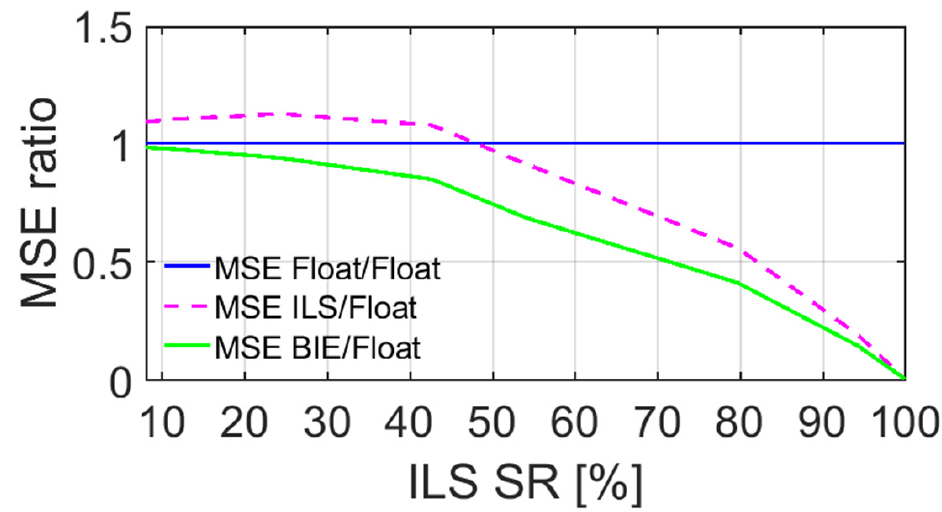
Figure 3. MSE ratios of GP4 single-frequency, short-baseline, and instantaneous RTK positioning errors using external antennas, with BIE (green line), ILS (dashed magenta line), and ambiguity float (blue line), all versus the float solutions.